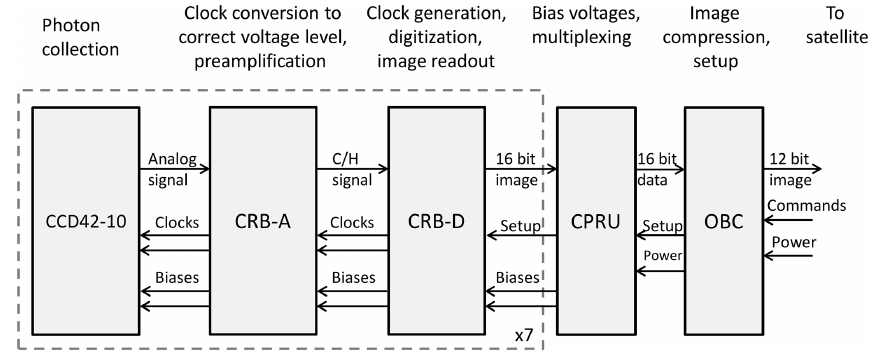
Figure 5. Overview of the MATS image acquisition. CCDs are controlled and read out by CCD Readout Boxes (CRB-A and CRB-D), connected to the CCD power regulation unit (CPRU) and on-board computer